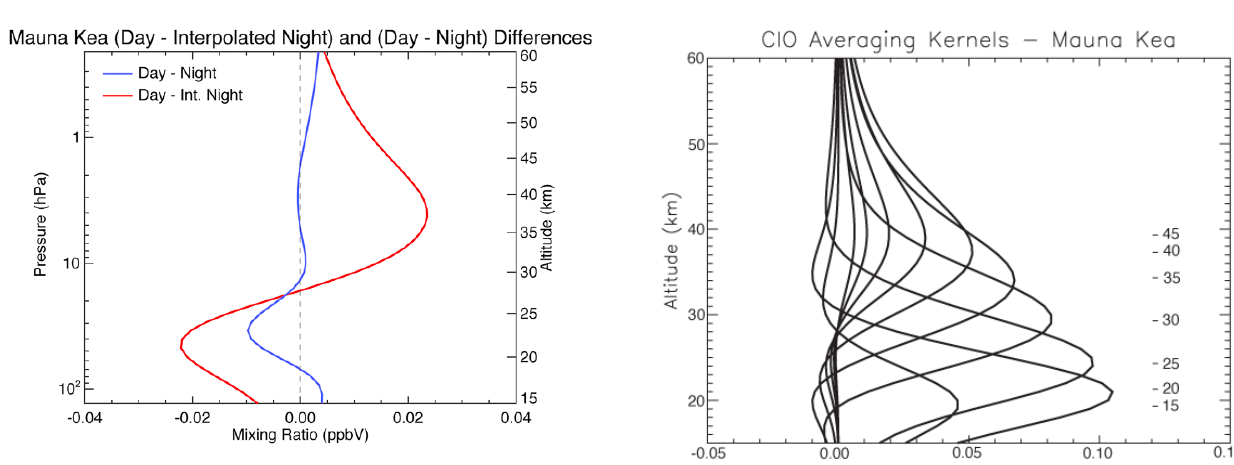
Fig. 5. The averaging kernels of the Mauna Kea ClO retrieval for selected altitudes from 15 to 60km. The labels to the right indicate the actual peak altitude of the function for the specified altitude. The functions for 50, 55, and 60km are also shown; their amplitudes progressively decline, while the maximum value of all 3 is at about 40km. They are not labeled to avoid